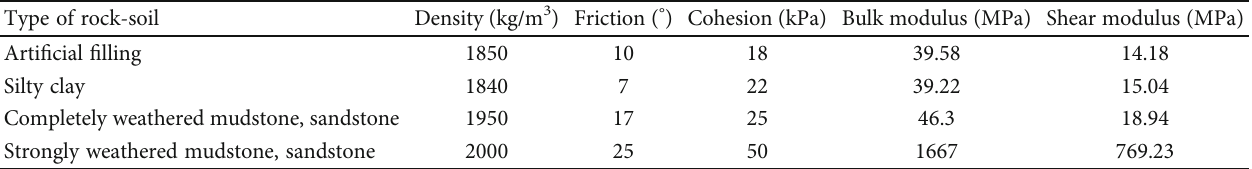
Table 4: Parameters of soil in natural